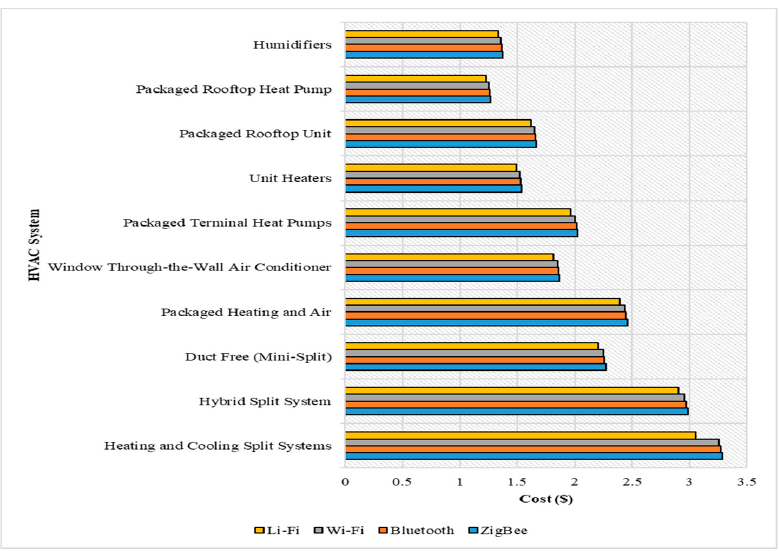
Figure 6. Communication costs ($) between various communication protocols using the CRNN system.